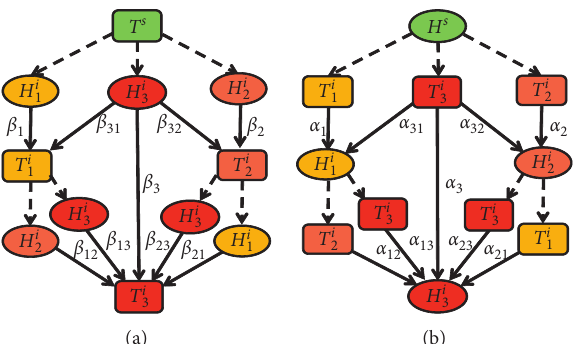
Figure 1: A transmission diagram of coinfection of two tick-borne pathogens among tick population (a) and host population (b),